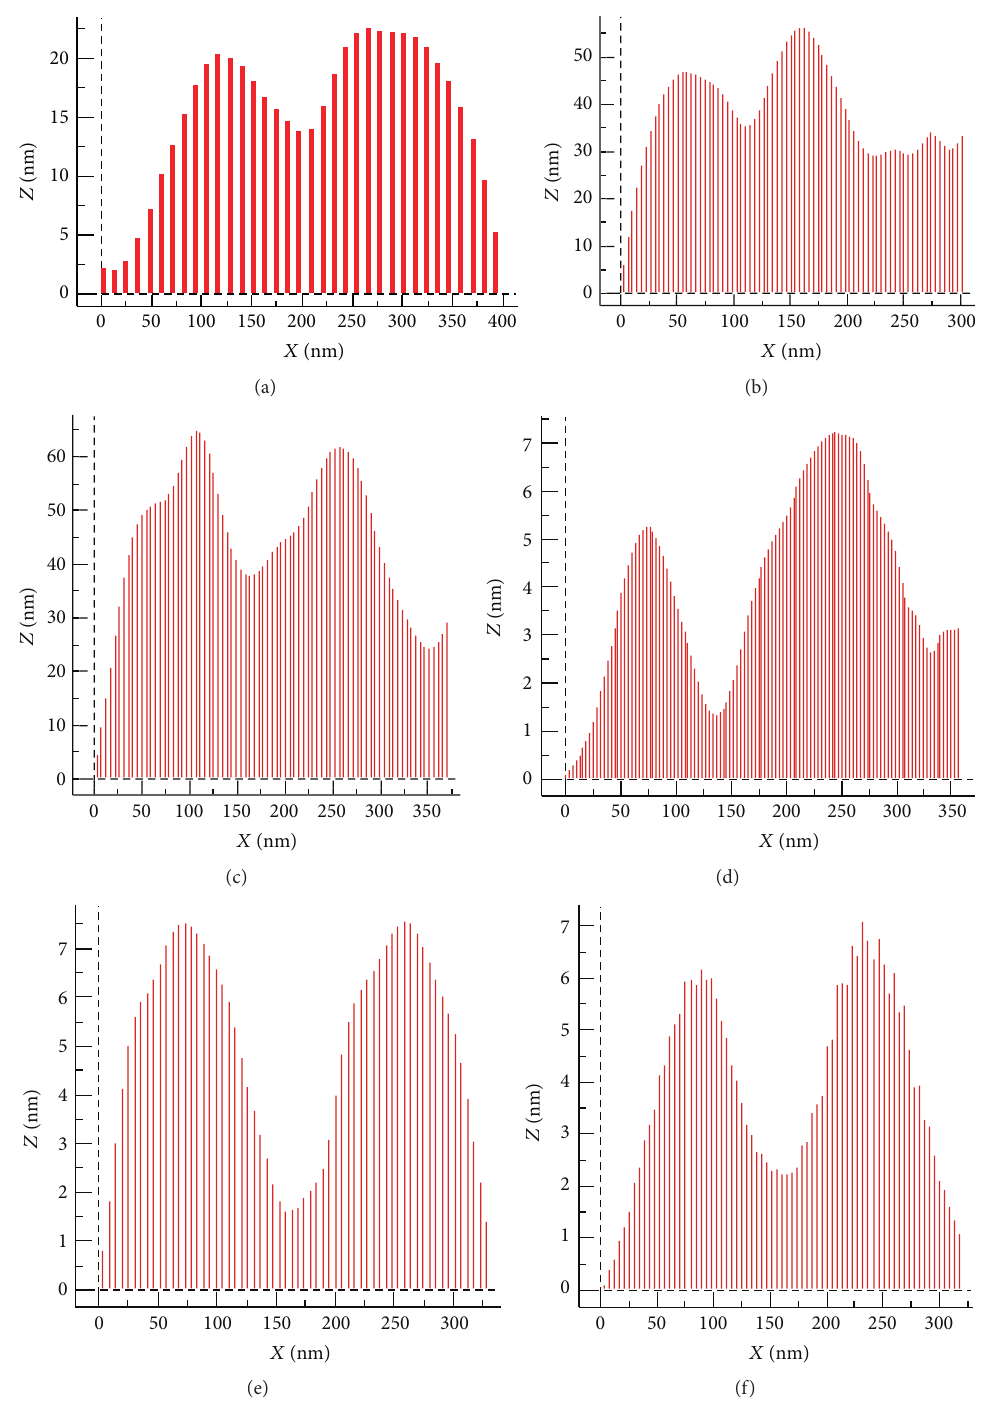
Figure 9: Profile curve of thiolated chitosan nanoparticles of Ch-SH/TPP nanoparticles prepared at pH 4, 4.3, 4.5, 4.7, 5, and 5.3.